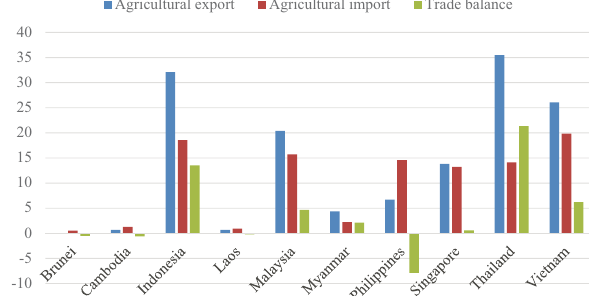
Figure 2: The share of agricultural export and import within the total export and import in the ASEAN, 2019. 2 Author ’ s composition based on the World Bank ’ s WITS ( 2020 ) database.